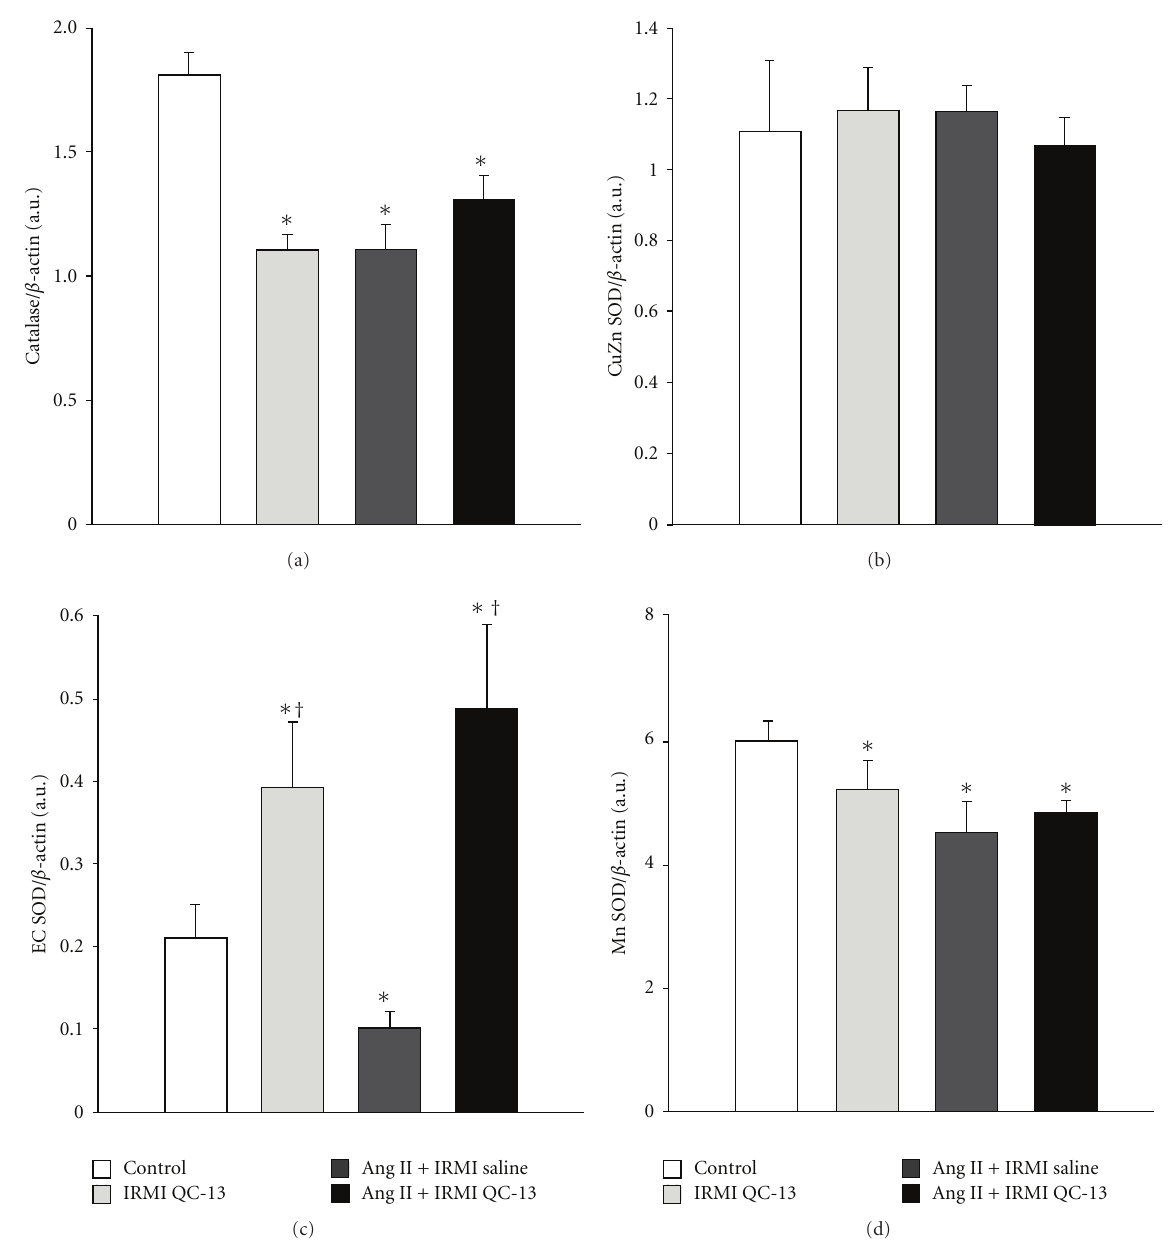
Figure 4: Representative western blots of catalase (a), copper-zinc (CuZn) superoxide dismutase (SOD) (b), extracellular (EC) SOD (c), and manganese (Mn) SOD (d) from the renal medulla of control, IRMI QC-13, Ang II + IRMI saline, and Ang II + IRMI QC-13-treated mice, n = 6/group. ∗ P < 0 . 05 as compared to value in control mice. † P < 0 . 05 as compared to Ang II-treated mice.